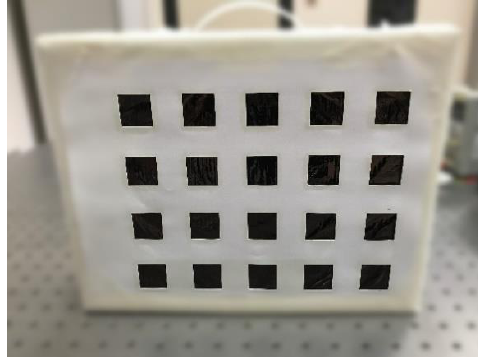
Figure 3. The calibration target.